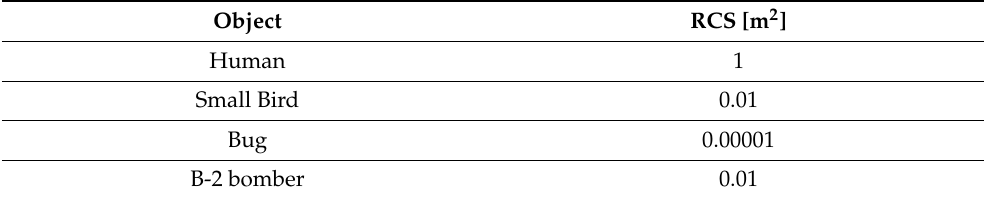
Figure 1. Detected RCS shape of military aircraft [2]. Table 1. Typical RCS values [3].